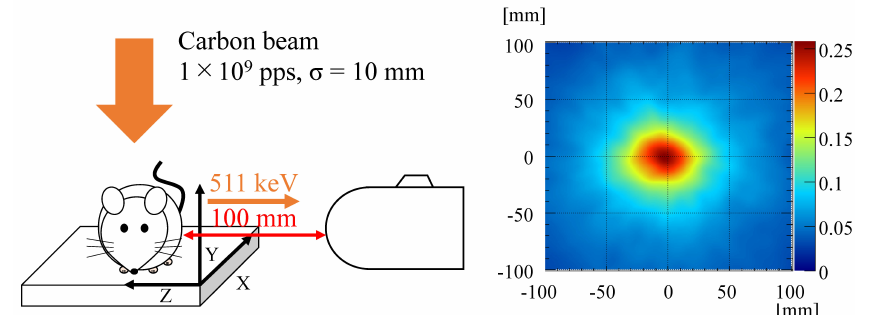
Figure 11. In vivo real-time monitoring of annihilation γ -rays generated by CIRT using Si/CdTe Compton camera. Experimental setup ( left ). Compton image of 511 keV annihilation gammas ( right ). Images have been rearranged and reprinted from Shiba et al. [87].